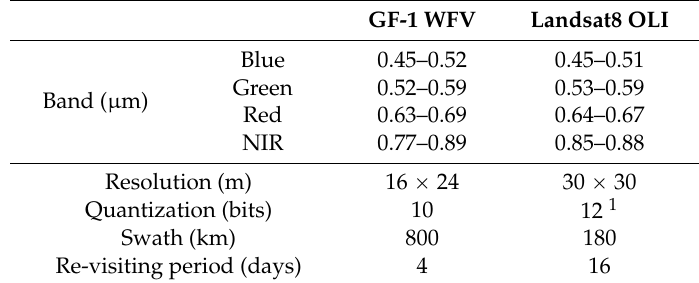
OLI (Operational Land Imager).